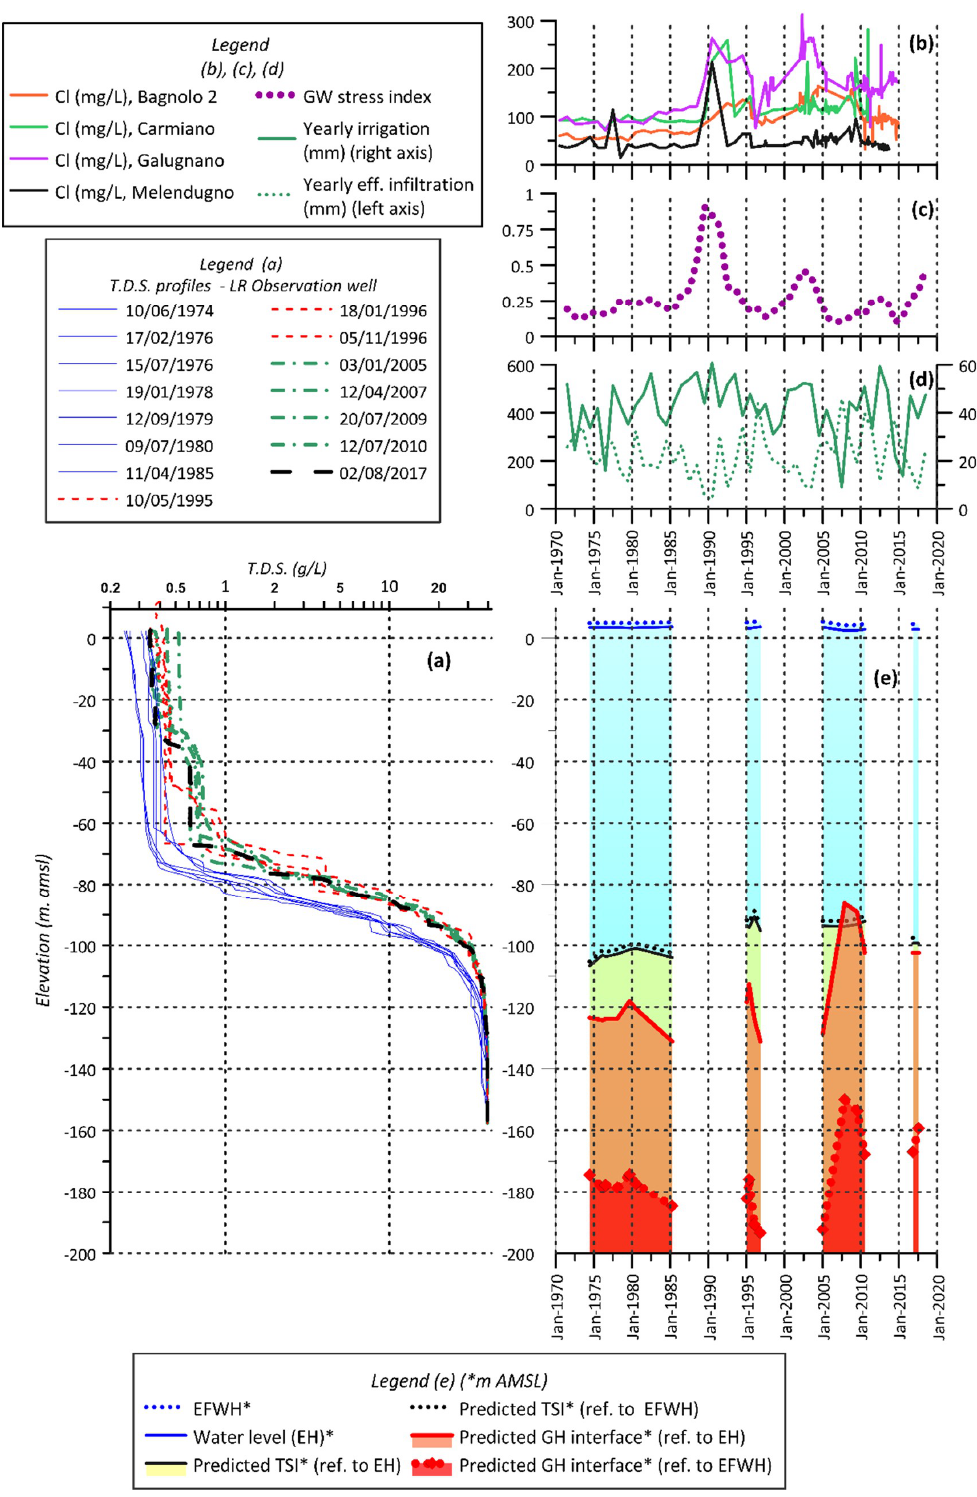
Figure 5. Time series of hydrological and hydrogeological data for the period 1974–2017 (karst coastal aquifer of Salento). ( a ) T.D.S. profiles at LR well (location in Figure 3a); ( b ) chloride concentrations at wells of AQP net; ( c ) groundwater stress (GW) index (moving average); ( d ) yearly effective infiltration (mm) and irrigation (mm); ( e ) with reference to LR observation well: water level (EH, environmental head), environmental freshwater head (EFWH), elevation of Ghyben–Herzberg (GH) interface and theoretical sharp interface (TSI) predicted on the base of both EH and EFWH.